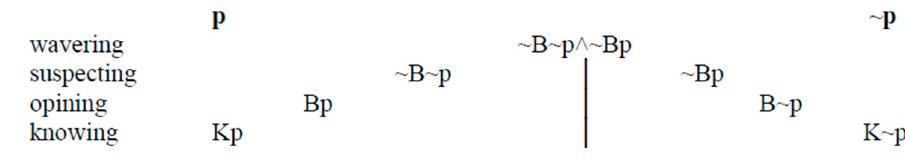
Figure 13. St. Thomas Aquinas’s “epistemic calculus”.